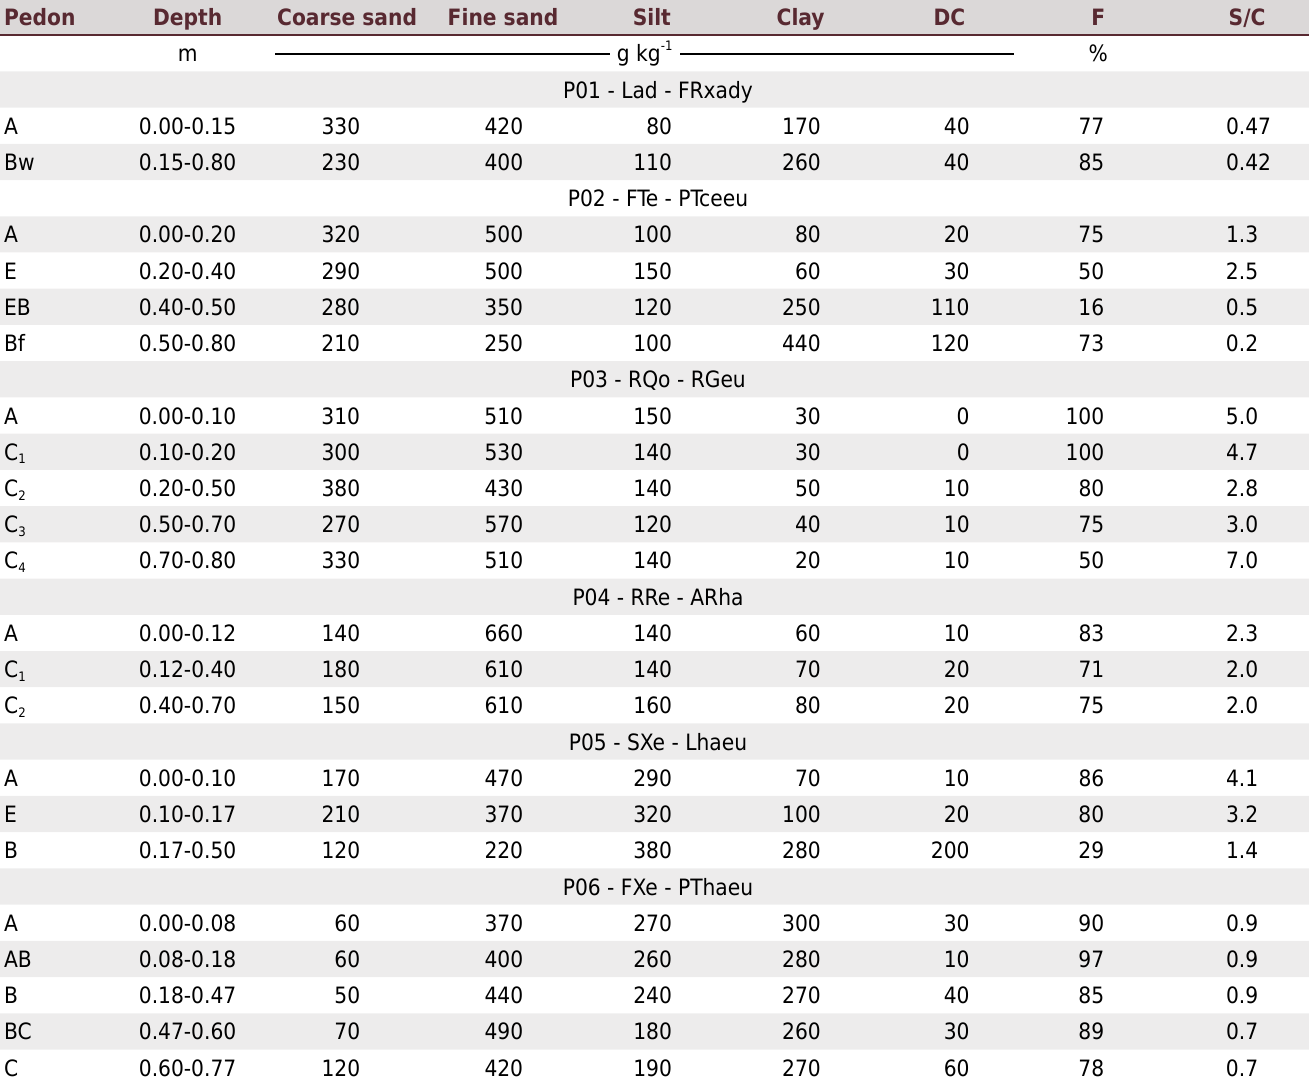
Table 2. Physical properties of soils classified according to the SiBCS (1) and WRB/FAO - Malhada Grande, northern Minas Gerais, Brazil Pedon Depth